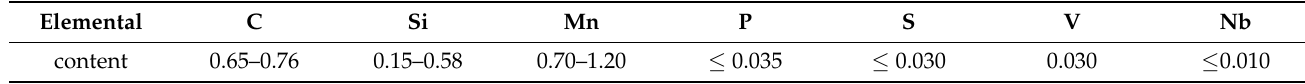
Table 1. Chemical compositions (wt%) of U71Mn rail steel [27].